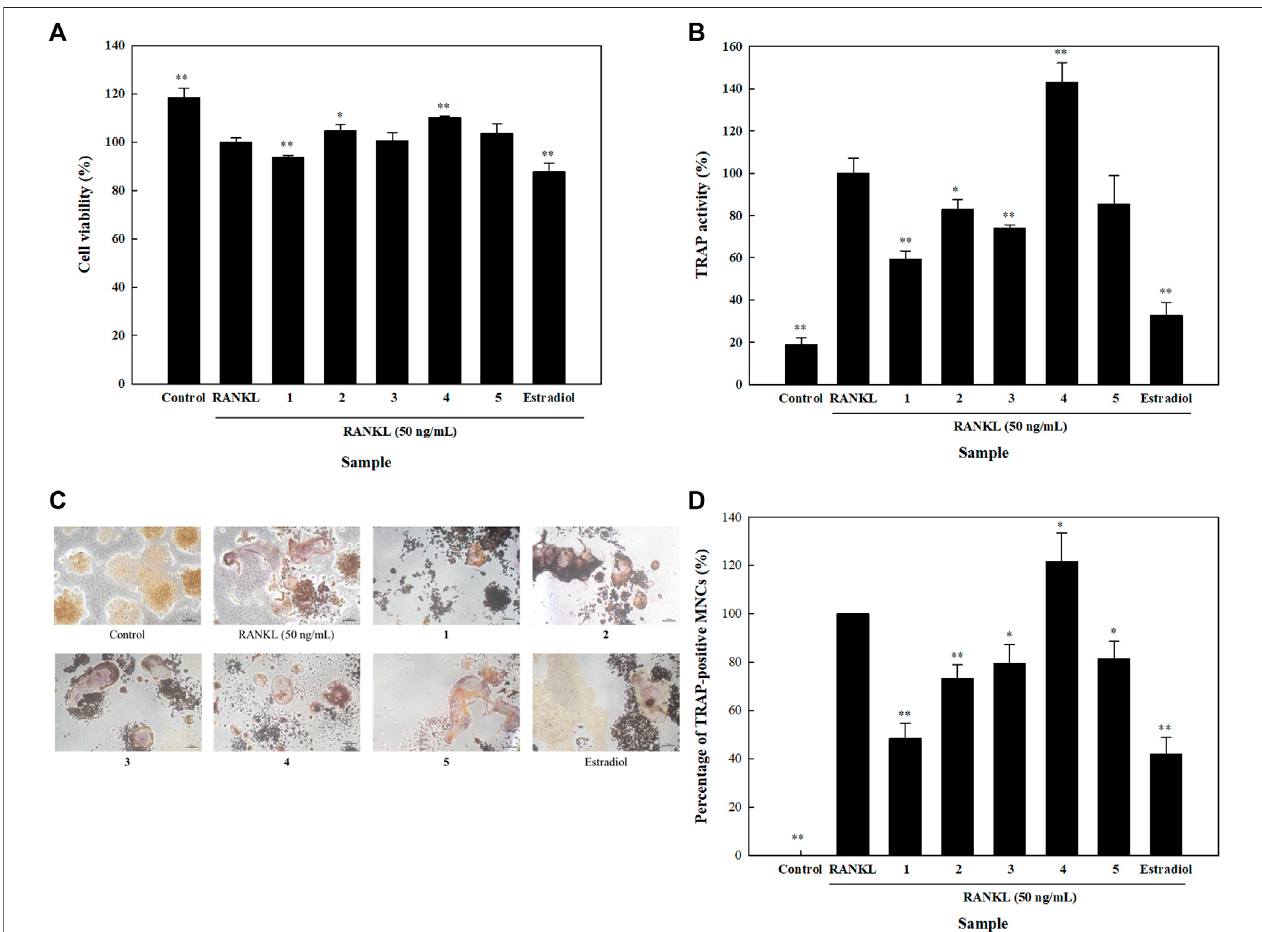
FIGURE 6 | Effects of isolated compounds on cell viability, tartrate-resistant acid phosphatase (TRAP) activity and TRAP staining in receptor activator of nuclear factor- κ B ligand (RANKL)-induced osteoclasts. Cells were seeded on 96-well plates for ( A ) cell viability and (B) TRAP activity assays. RANKL and samples were added 24 h after seeding, and detection assays were performed 5 days later. (C) For TRAP staining, cells were seeded in 24-well plates, and RANKL and samples were alternatively added. A leukocyte acid phosphatase kit was utilized after 5 days. (D) Quanti fi cation of TRAP-positive multinucleated cells (MNCs). Experiments were carried out in triplicate. * p < 0.05 and ** p < 0.01; data are presented as the mean ± standard deviation. 1 , astragalin; 2 , kaempferol 3- O - β ;- D -apiofuranosyl-(1 → 6)- β - D -glucopyranoside; 3 , adenosine; 4 , tryptophan; and 5 , 2,5-dimethoxy-3- O - β - D -glucopyranosyl cinnamic alcohol.